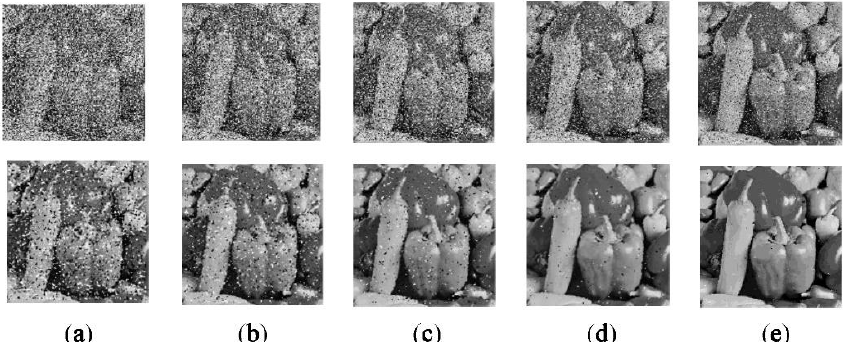
Figure 2. Restored Images with TASOM from 20% to 60% density of impulsive noise; ( a ) 60%, ( b ) 50%,